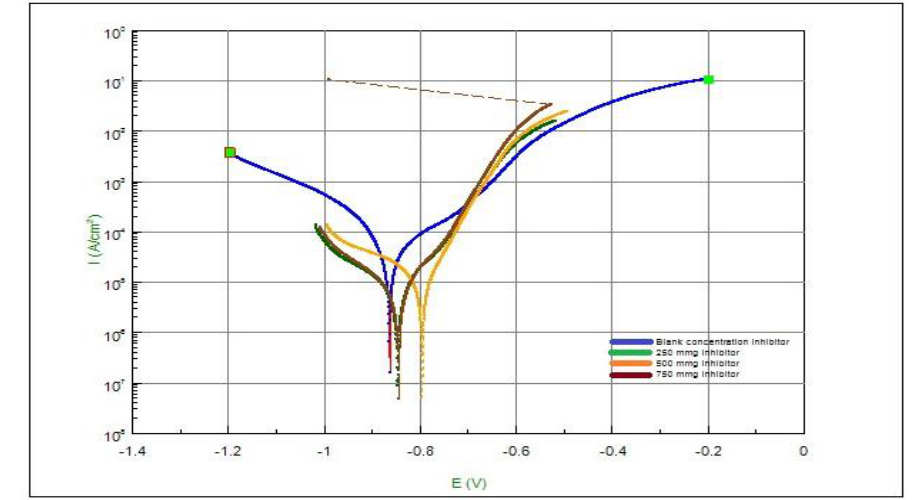
Fig. 5. Variation of inhibitor concentration on current density and voltage at